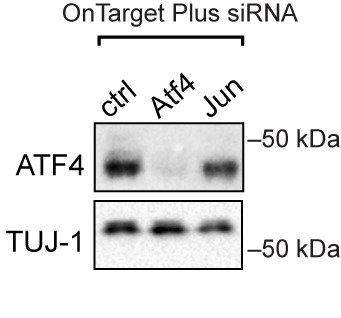
Targeted silencing of ATF4 by OnTarget Plus siRNA pool verified by immunoblotting.